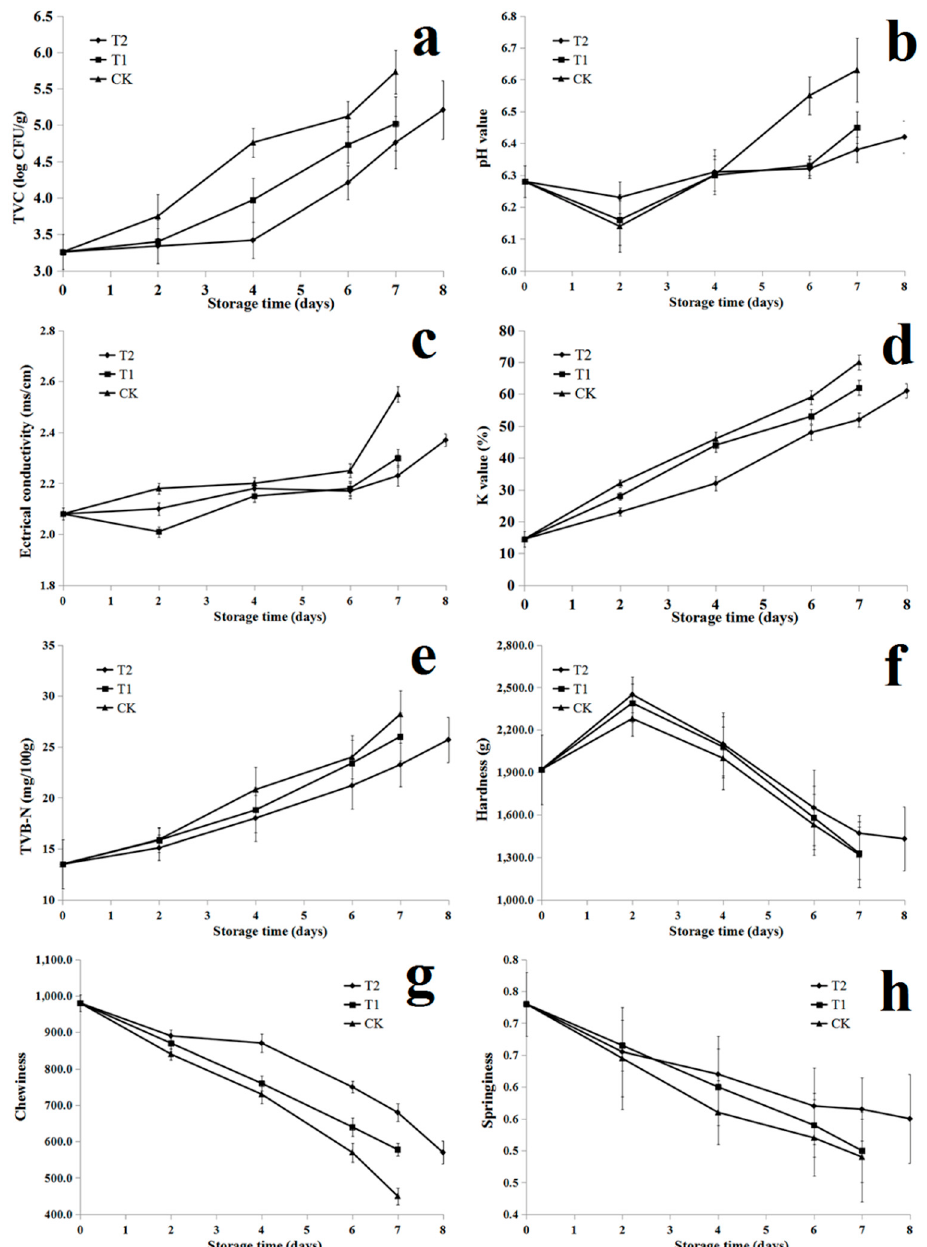
Figure 1. Change in the total viable counts (TVC, a ), pH value ( b ), electrical conductivity ( c ), K value ( d ), total volatile basic nitrogen (TVB-N, e ), hardness ( f ), chewiness ( g ) and springiness ( h ) of salmon ( c ), total volatile basic nitrogen (TVB ‐ N, c ), hardness ( d ), chewiness ( e ) and springiness ( f ) of salmon treated with bacteriocin EFL4 during cold storage at 4 ◦ C (CK: control; T1: salmon treated with 1MIC treated with bacteriocin EFL4 during cold storage at 4 °C (CK: control; T1: salmon treated with 1MIC bacteriocin EFL4; T2: salmon treated with 2MIC bacteriocin bacteriocin EFL4; T2: salmon treated with 2MIC bacteriocin EFL4).